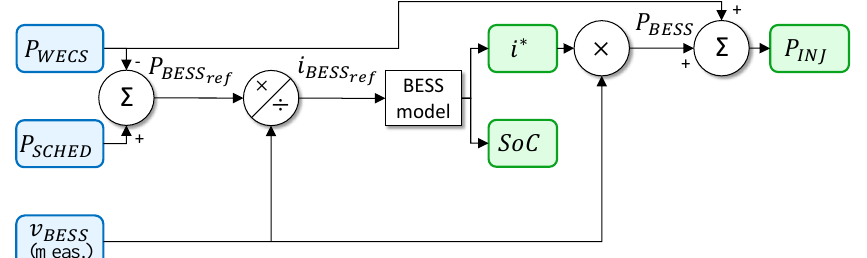
Figure 16. BESS model control